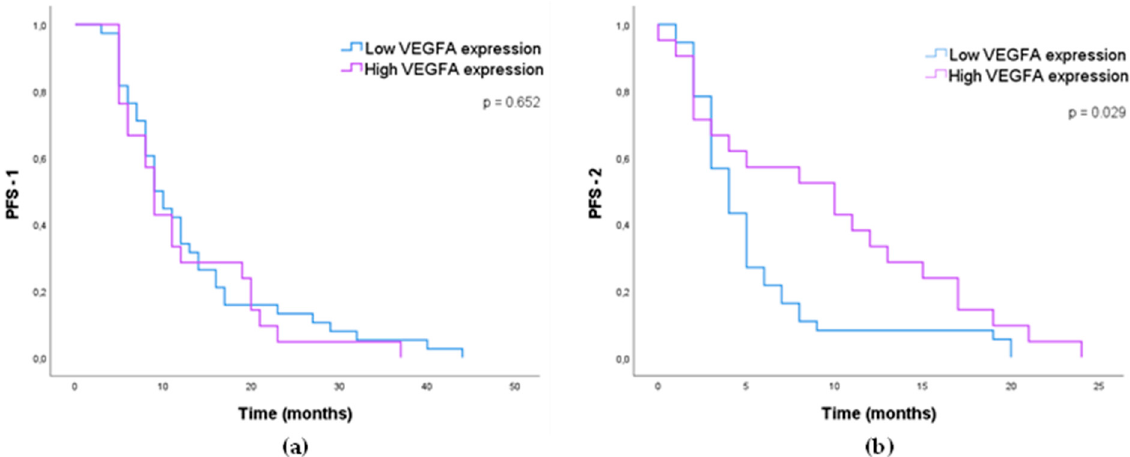
Figure 2. Kaplan–Meier analysis of progression-free survival (in months) after temozolomide treat- ment (PFS-1) ( a ) and bevacizumab treatment (PFS-2) ( b ) according to VEGFA expression.